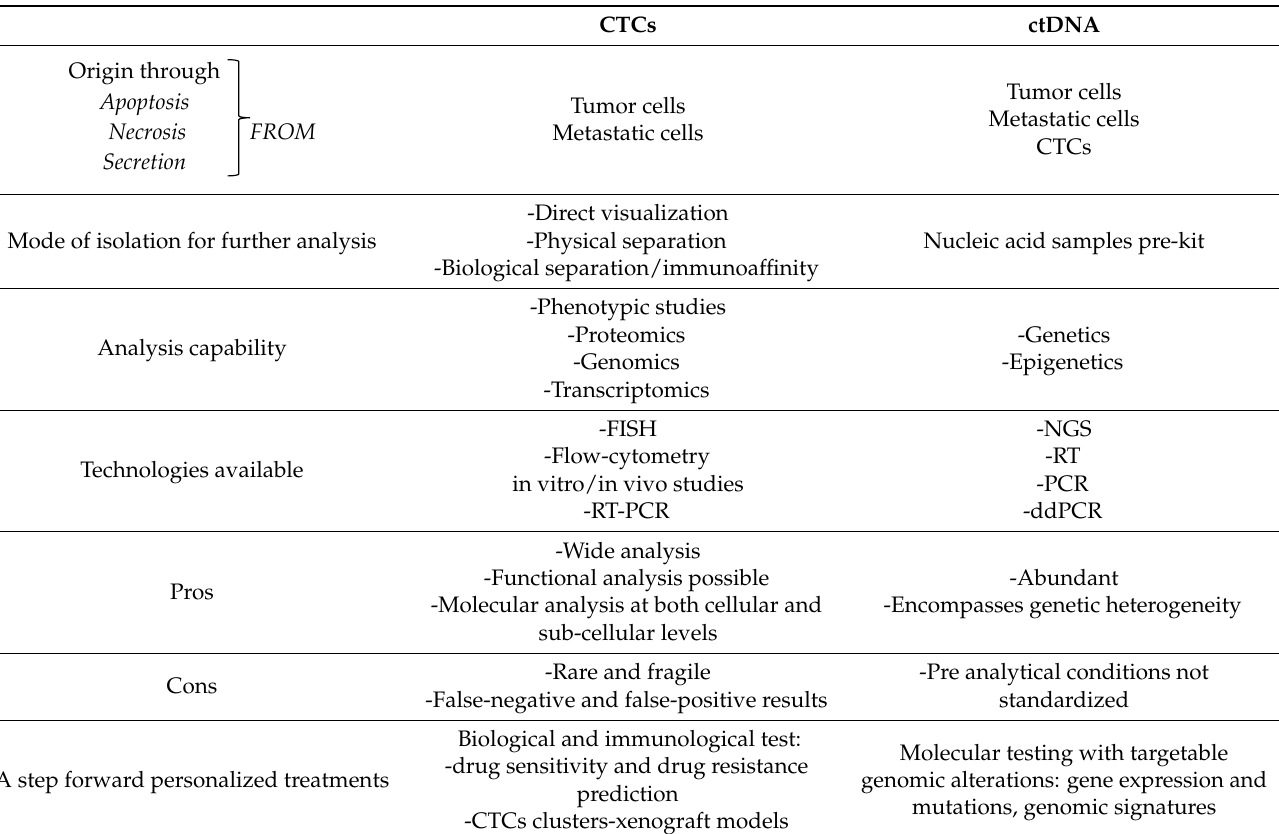
Table 1. Liquid biopsy: CTCs and ctDNA.